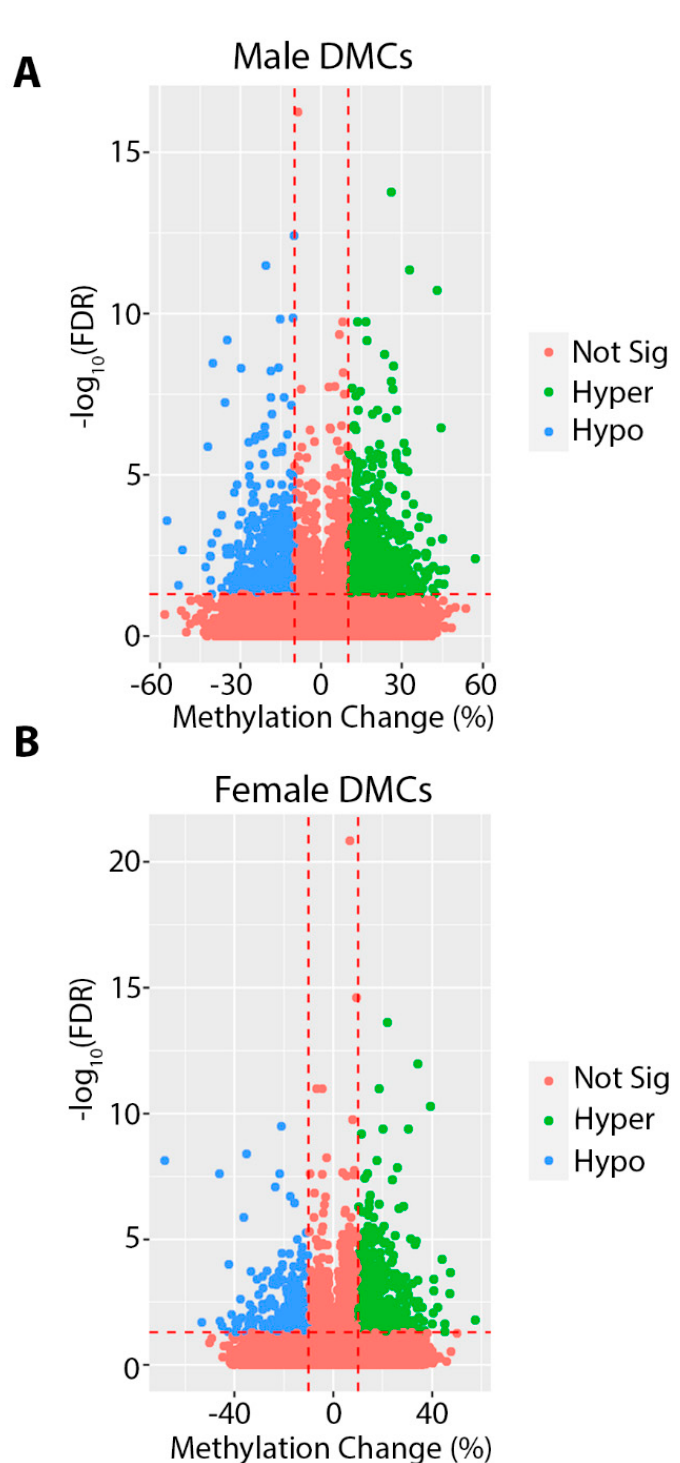
Figure 3. Volcano plots depicting differentially methylated cytosines (DMCs) for Pb exposed com- pared to control in males ( A ) and females ( B ). DMCs in red did not meet the criteria for significance (at least a 10% change in methylation and FDR < 0.05). Significantly hypomethylated DMCs are shown in blue, and significantly hypermethylated DMCs are shown in green.